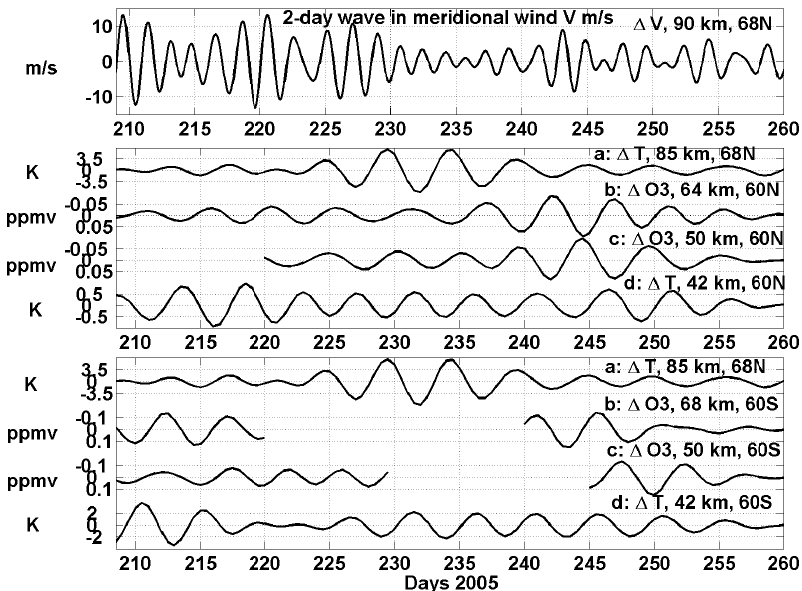
Fig. 7. Wave perturbations for 27 July–17 September 2005: Upper panel: 2-day wave from ground-based radar measurements of meridional wind (m/s) over Esrange (67 ◦ 56 0 N, 21 ◦ 04 0 E), at 90km. Middle panel: 5-day perturbations: (a) from ground-based radar measurements of temperature over Esrange (67 ◦ 56 0 N, 21 ◦ 04 0 E), at 85km. (b–d) from Odin retrievals at latitude=60 ◦ N, longitude=21 ◦ E: for ozone (ppmv) at 64km (b) and at 50km (c), for temperature (K) at 42km (d), (Note: reverse scale for ozone). Lower panel: (a) same as on the middle panel. (b–d) from Odin retrievals at latitude=60 ◦ S, longitude=21 ◦ E: for ozone (ppmv) at 68km (b) and at 50km (c), for temperature (K) at 42km (d), (Note: reverse scale for